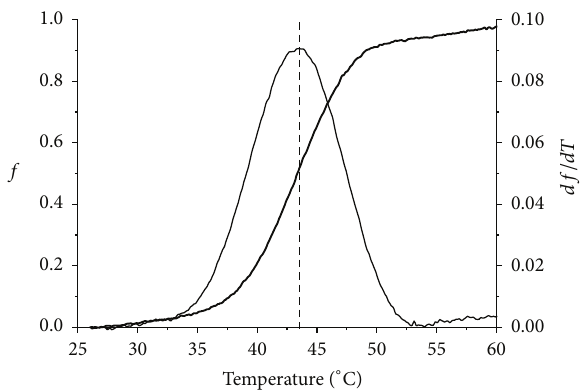
Figure 1: The normalized melting curve 𝑓(𝑇) ( bold line ) and the corresponding first derivative ( 𝑑𝑓/𝑑𝑇 ) of pure DNA in 0.25 mM EDTA/0.2 mM NaCl